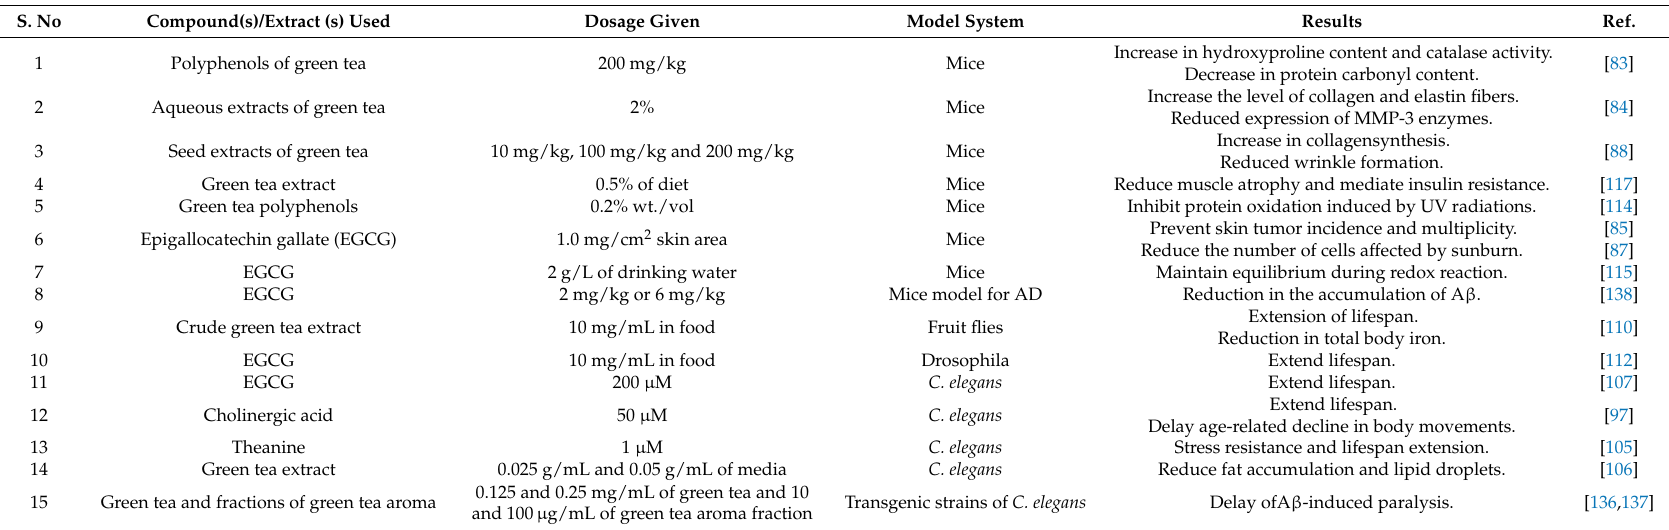
Table 1. Effects of green tea supplementation on photoaging, stress resistance, neuroprotection, and associated health complications: Results of in